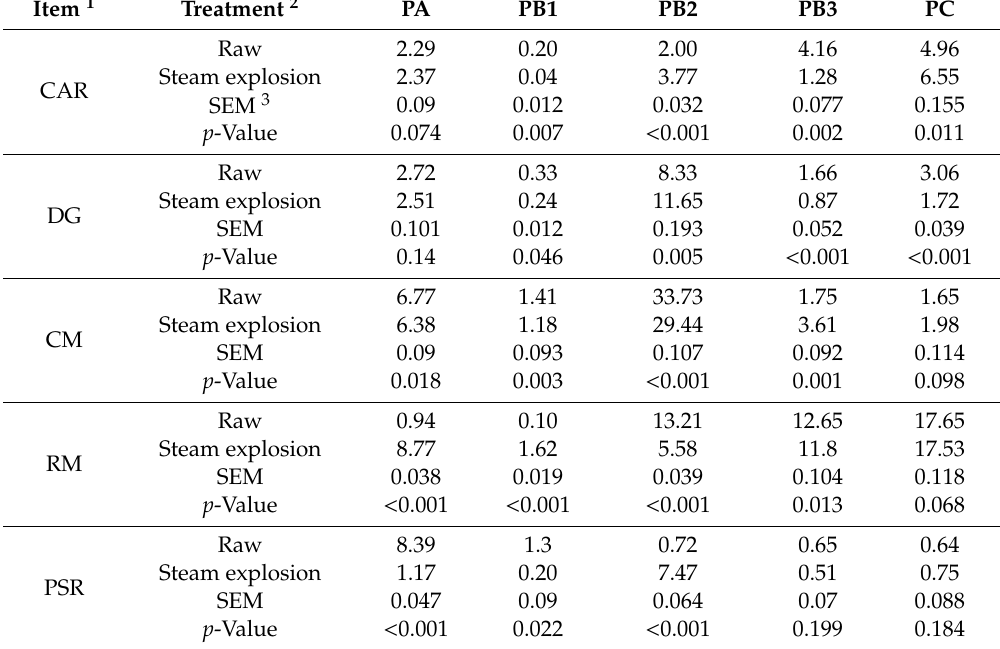
Table 4. E ff ect of steam explosion on the protein composition of five byproduct feedstu ff s (DM basis, expressed as